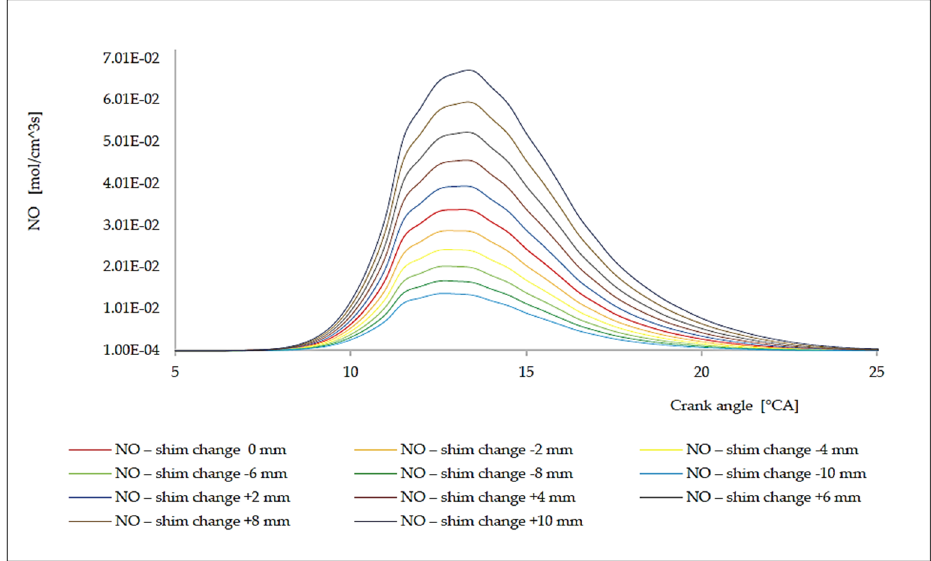
Figure 12. Dependence of NO concentration on the change in compression ratio at 50% MCR [22].